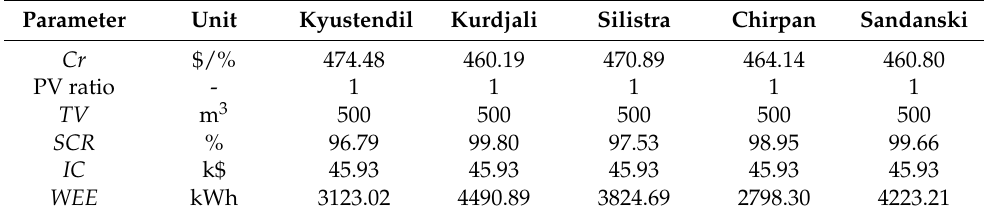
Figure 13. SCR (%) for cherries with a 12.5 kW HRES, using uSi PV technology and WT type 3 for each site: ( a ) Kyustendil; ( b ) Kurdjali; ( c ) Silistra; ( d ) Chirpan; ( e ) Sandanski. Table 6. Optimal configurations for each site with cherries and a 12.5 kW HRES, using uSi PV panels and WT type